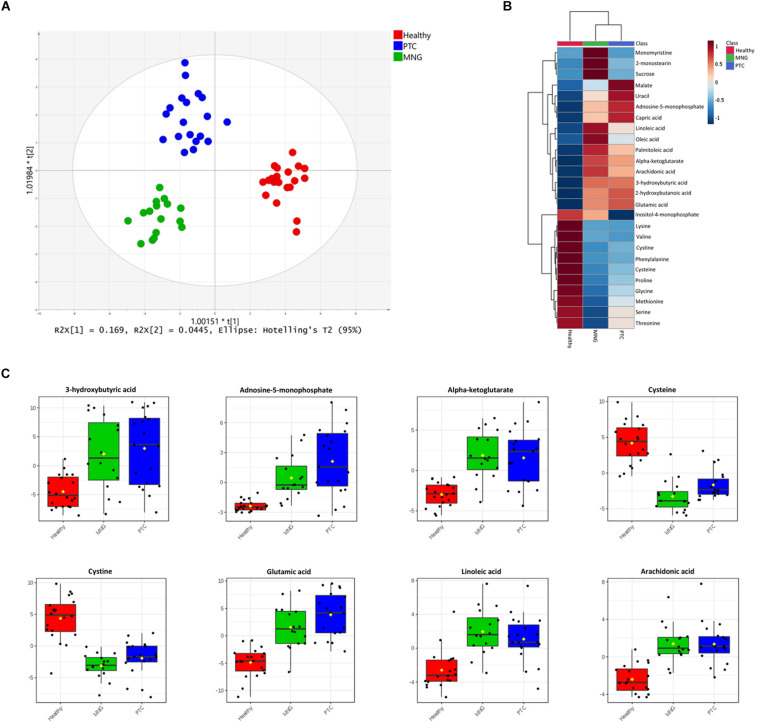
(A) OPLS-DA analysis score scatter plots for metabolic profiles of the MNG (green dots), PTC (blue dots), and healthy (red dots) groups showing clear discrimination between the three groups. (B) Heatmap visualization of metabolomics data with hierarchical clustering analysis (HCA). Average (mean) intensity was used to indicate the level of difference for single metabolites among three groups. (C) Boxplots of the eight most significant metabolites (P < 0.05) in the analysis of variance results comparing the three groups (PTC; blue boxes, MNG; green boxes and healthy; red boxes). The x-axis shows the specific metabolite and the y-axis is the normalized peak intensity. OPLS-DA; orthogonal partial least squares-discriminant analysis, PTC; papillary thyroid carcinoma, MNG; multinodular goiter.